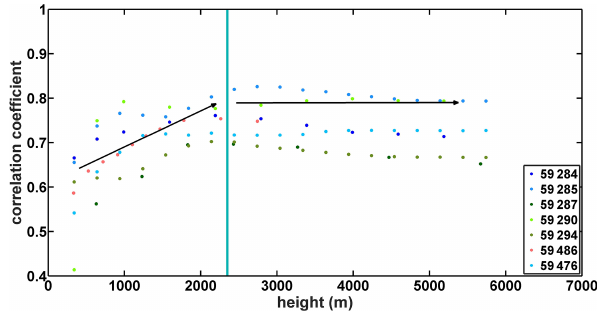
Figure 5. Correlation coefficient between the evolution of average wind speed and the evolution of ground ozone concentration in dif- ferent altitude ranges of each wind profile radar station.